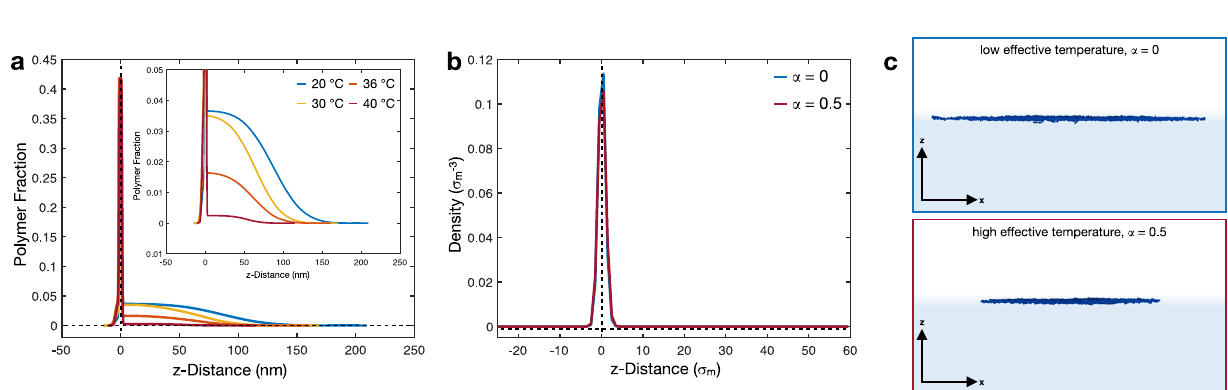
Fig. 5 Structure of ULC microgels at liquid interfaces. a Results of the fi ts of the experimental data for the ULC D3 microgels. Inset: Zoom of the polymer fraction pro fi les. b Density pro fi les of simulated ultra-low cross-linked microgels at different effective temperatures, corresponding to α = 0, and 0.5. Horizontal and vertical dashed lines are guides to the eyes and represent zero polymer fraction and zero z-distance from the interface, respectively. Negative values of z represent the air phase and positive values represent the water phase. c Simulation snapshots showing the side perspective of an adsorbed ULC microgel for α = 0, 0.5. Solvent particles are not shown for visual